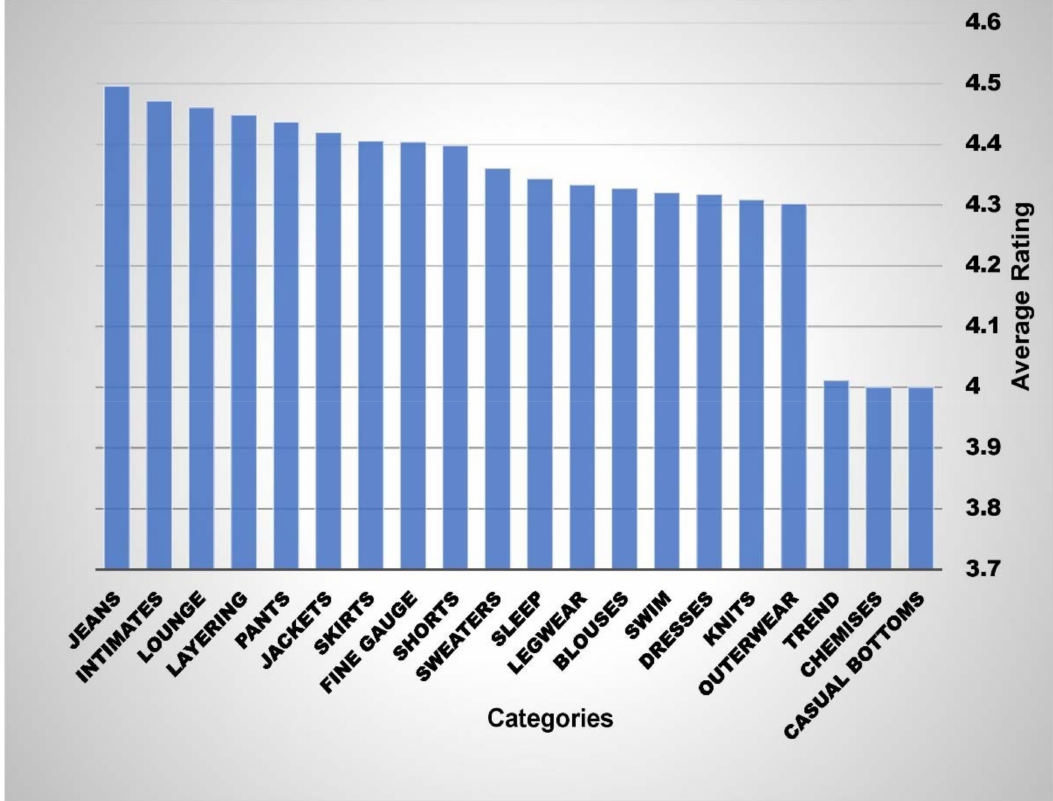
Figure 6. Product categories comparison based on